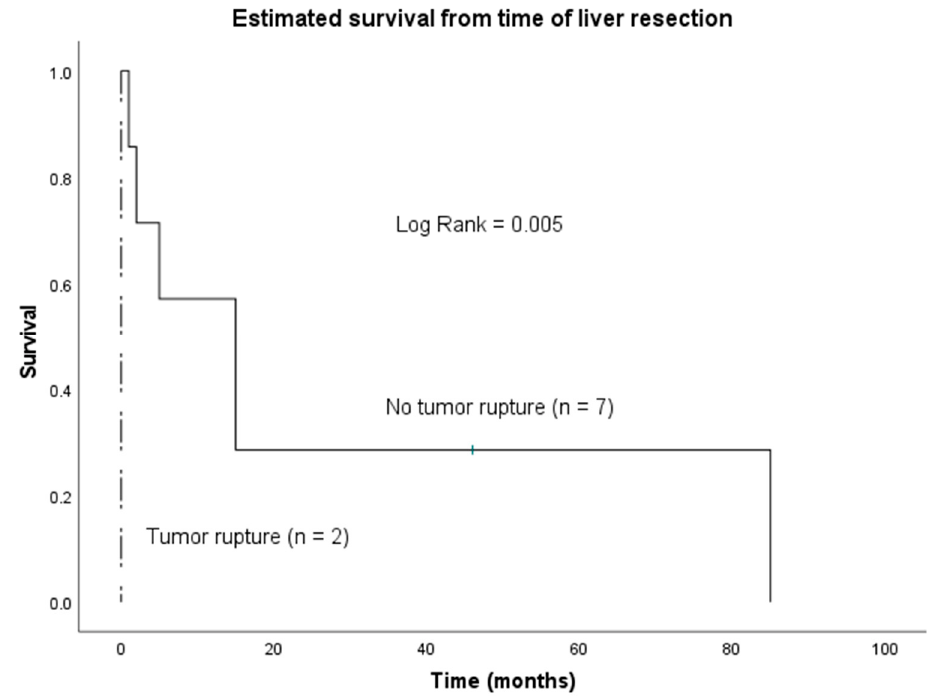
Figure 3. Overall survival of patients undergoing hepatectomy for PHA according to the presentation with or without tumor rupture. Table 2. Cox regression of parameters on overall survival .